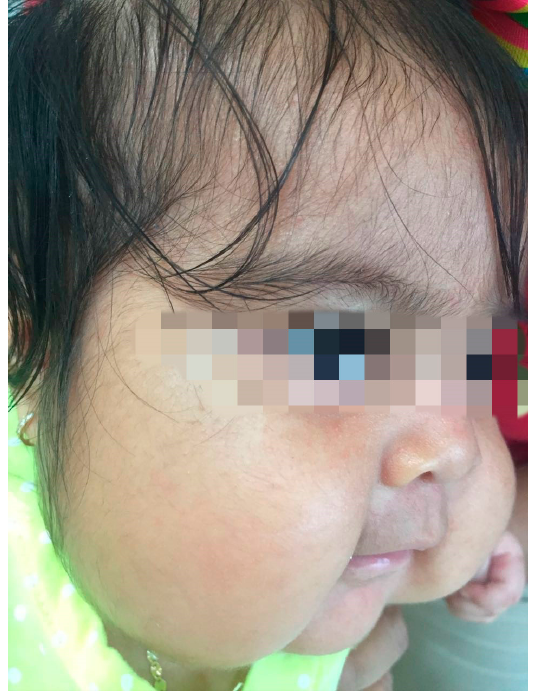
Figure A1. Infant with increased adiposity and forehead hirsutism.